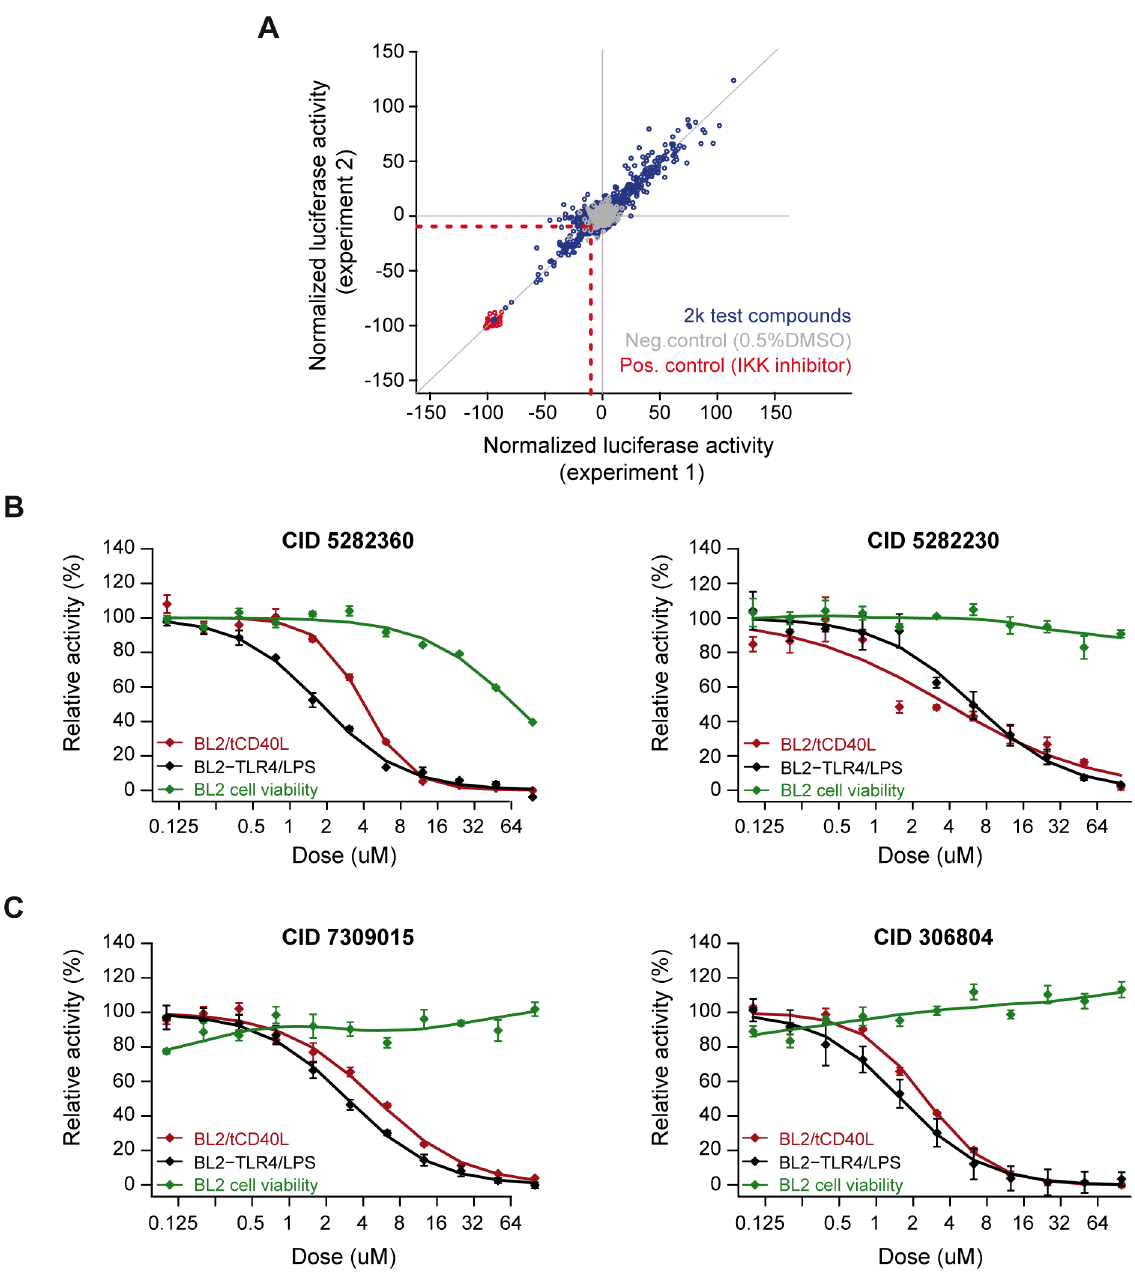
Figure 3. Small molecule screen of CD40-mediated NF-kB signaling in BL2 cells. (A) Results from duplicate experiments screening 1,982 compounds. Red circles are our positive control (IKK inhibitor VII); grey circles are our neutral controls (DMSO only); and blue circles are test compounds. The red dashed line indicates . 2SD from the mean of the neutral controls, which defines our ‘‘hit’’ compounds (n=81 compounds). (B) Dose-response curves for two compounds known to inhibit inflammation [CID=5282230 (tranilast)] or NF-|B signaling [CID=5282360 (4-hydroxy- estradiol)] in the BL2-NF|B-Luc cell lines. (C) Dose-response curves for two compounds not previously implicated in inflammation, NF- k B signaling, CD40 signaling, or other biological pathways related to rheumatoid arthritis: CID=306804, [4-(1-acetyl-4-oxo-2H-3,1-benzoxazin-2-yl)phenyl] acetate; and CID=7309015, 8-[(Z)-3-(3,4-dimethoxyphenyl)prop-2-enoyl]-7-hydroxy-4-methylchromen-2-one. Red line=cells activated with tCD40L; black line=cells activated with either CD40 or LPS (in BL2-TLR4-NF k B-Luc cells); green line=cell toxicity, as measured by